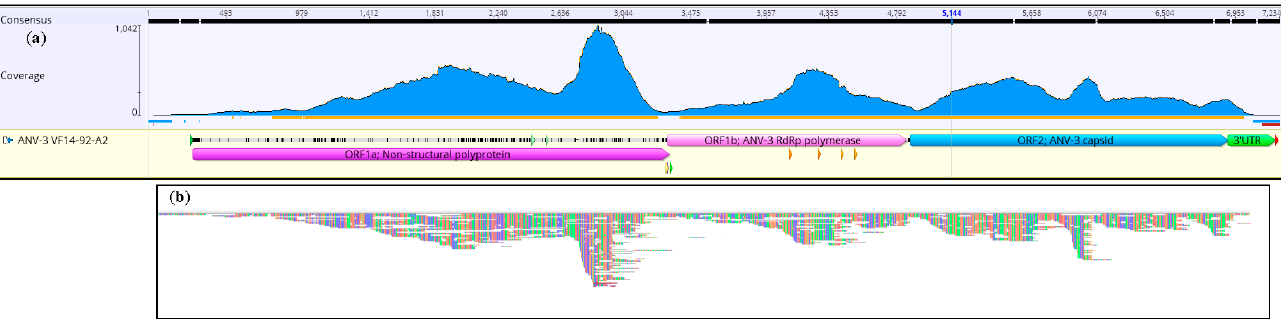
Figure 4. Genome coverage of ANV-3. ( a ) The whole genome coverage validation of ANV-3 reads from MT585643 VF14-92-A2 with MT585644 VF16-03-164b used as a reference sequence. The Geneious read mapping algorithm, set at 5 iterations, resulted in whole genome coverage with 9241 reads. The ORF1a 3 ′ region had the highest coverage at a 1042 read depth. ( b ) The BWA-MEM read aligner/Tablet visualisation showed a similar profile to Geneious and whole genome breadth and depth of coverage.